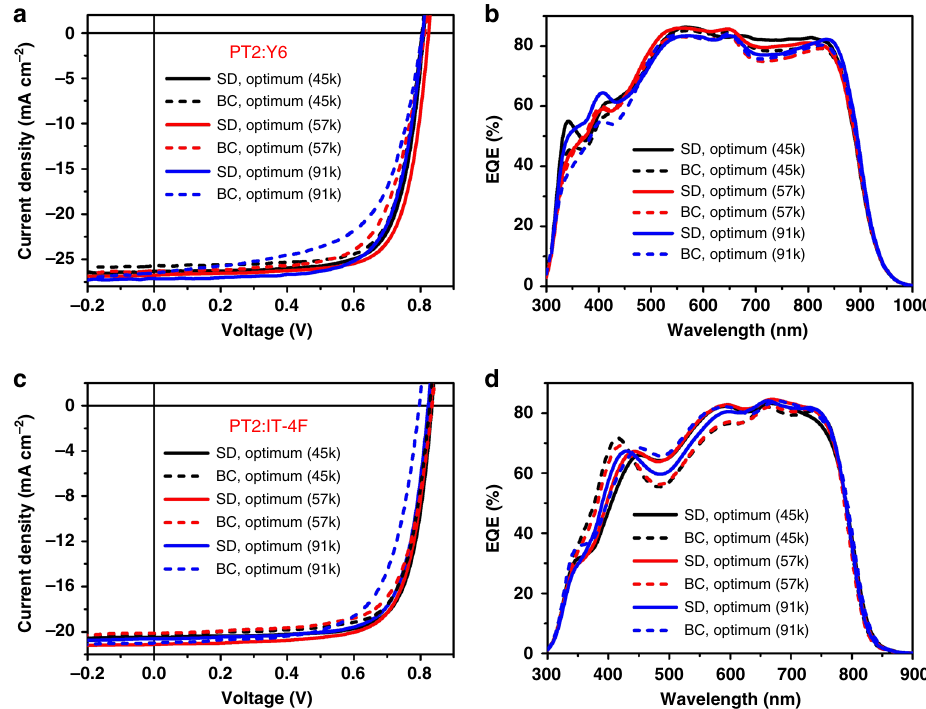
Fig. 5 Photovoltaic performance of OSCs based on different PT2 batches. a,c J – V characteristics of SD and BC OSCs fabricated with different PT2 batches under constant incident light intensity (AM 1.5 G, 100 mWcm − 2 ), and b,d the corresponding EQE spectra. Table 2 Summary of device parameters of SD and BC OSCs.